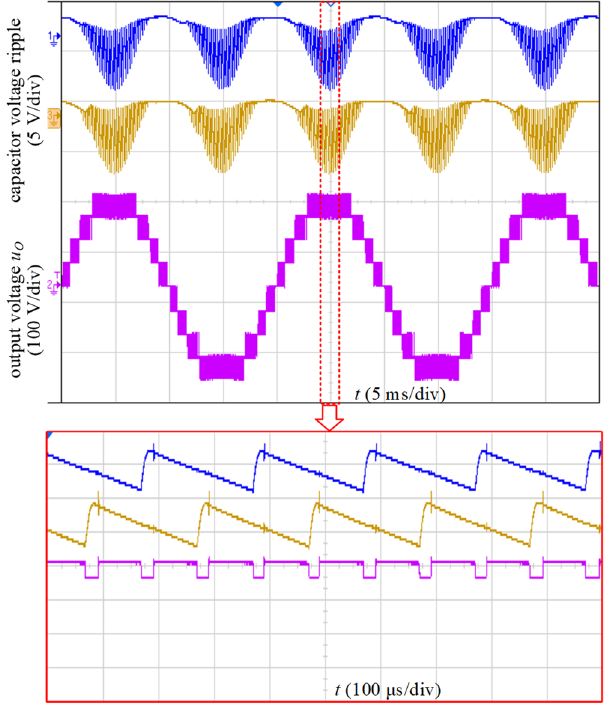
Figure 13. Experimental waveforms for a resistive load.